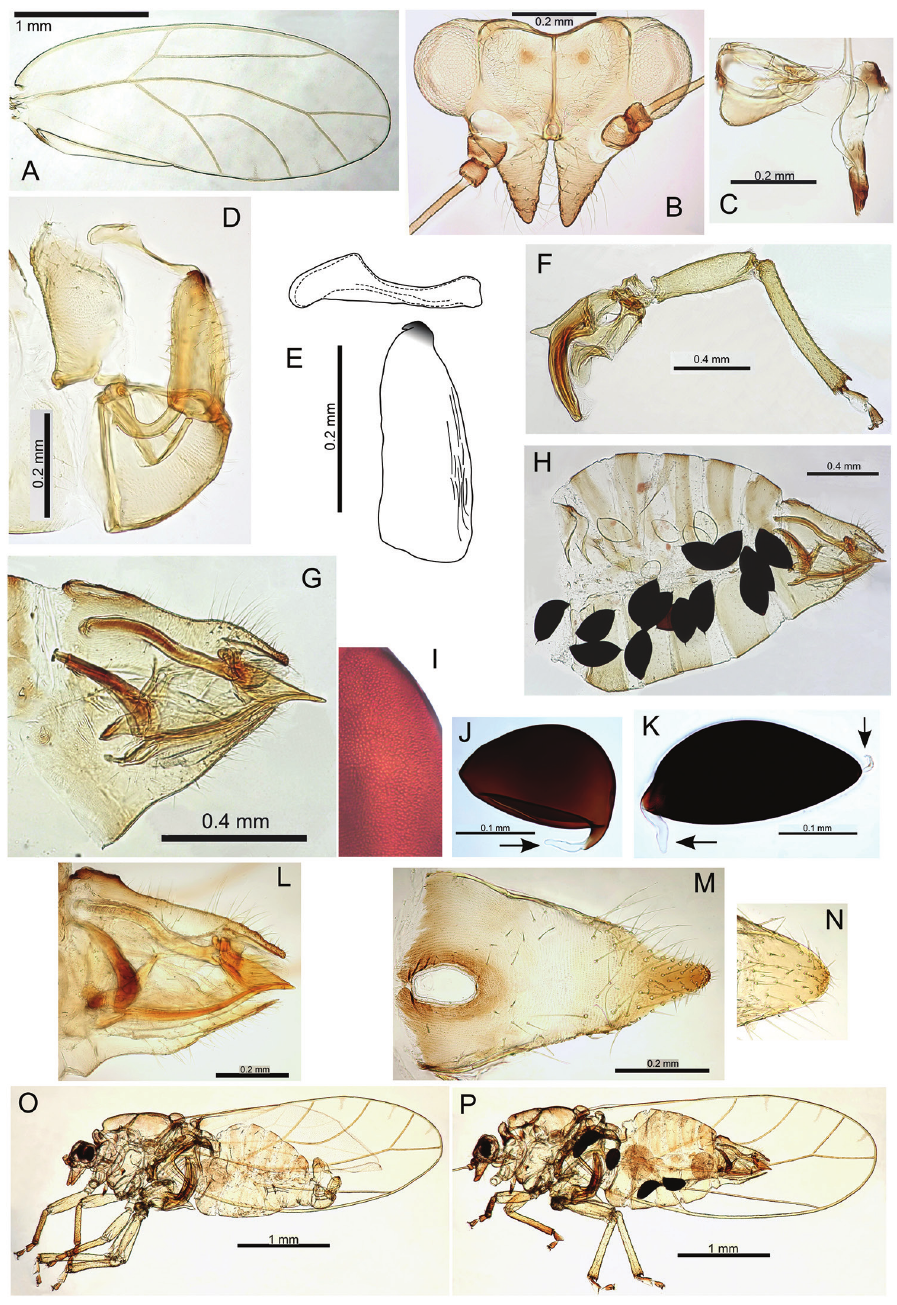
Figure 41. Pariaconus hawaiiensis . A fore wing B head C proboscis D male terminalia E aedeagus and paramere F hind leg G female terminalia (Kipuka Alani, Hawaii) H female abdomen (with eggs) I, J, K eggs (pedicel and tail indicated, microsculpturing detailed) L female terminalia (Kona Hema, Ha- waii) M female proctiger (dorsal view) N apex of female subgenital plate (ventral view) O male P